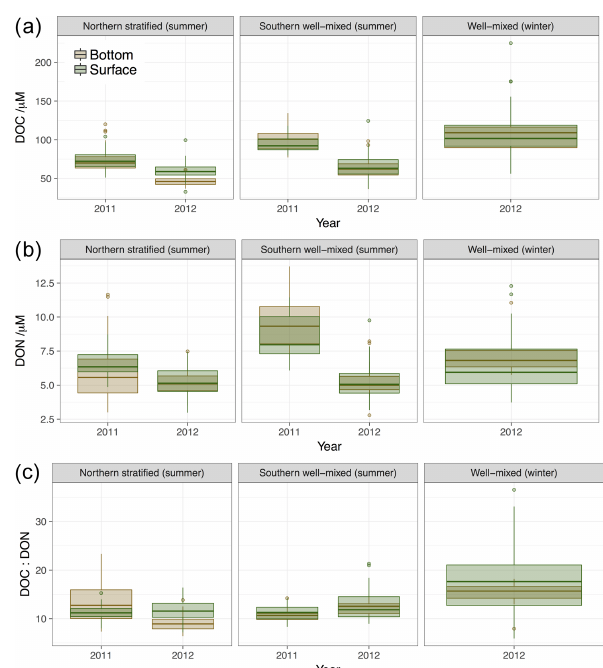
Figure 7. Summary of DOM concentrations (a) DOC, (b) DON and (c) DOM C : N ratio. Box and whisker plots show statistical sum- mary of the data where the thick horizonal line represents the me- dian value, the extent of the boxes represents the interquartile range and whiskers represent the full range of data to 1.5 interquartile dis- tances from the median. Any points outside this range are shown as discrete